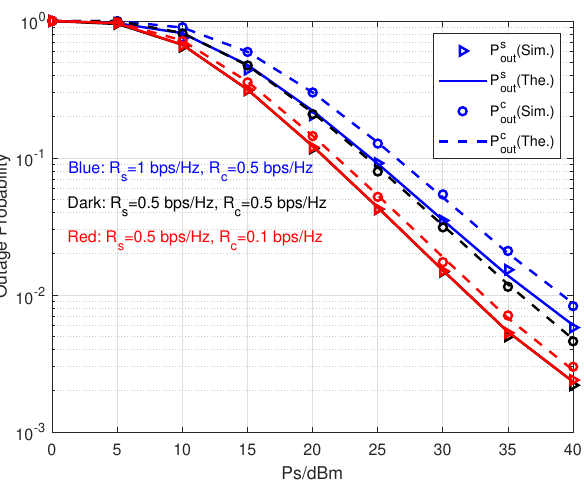
Figure 3. Outage probabilities versus P s with different information